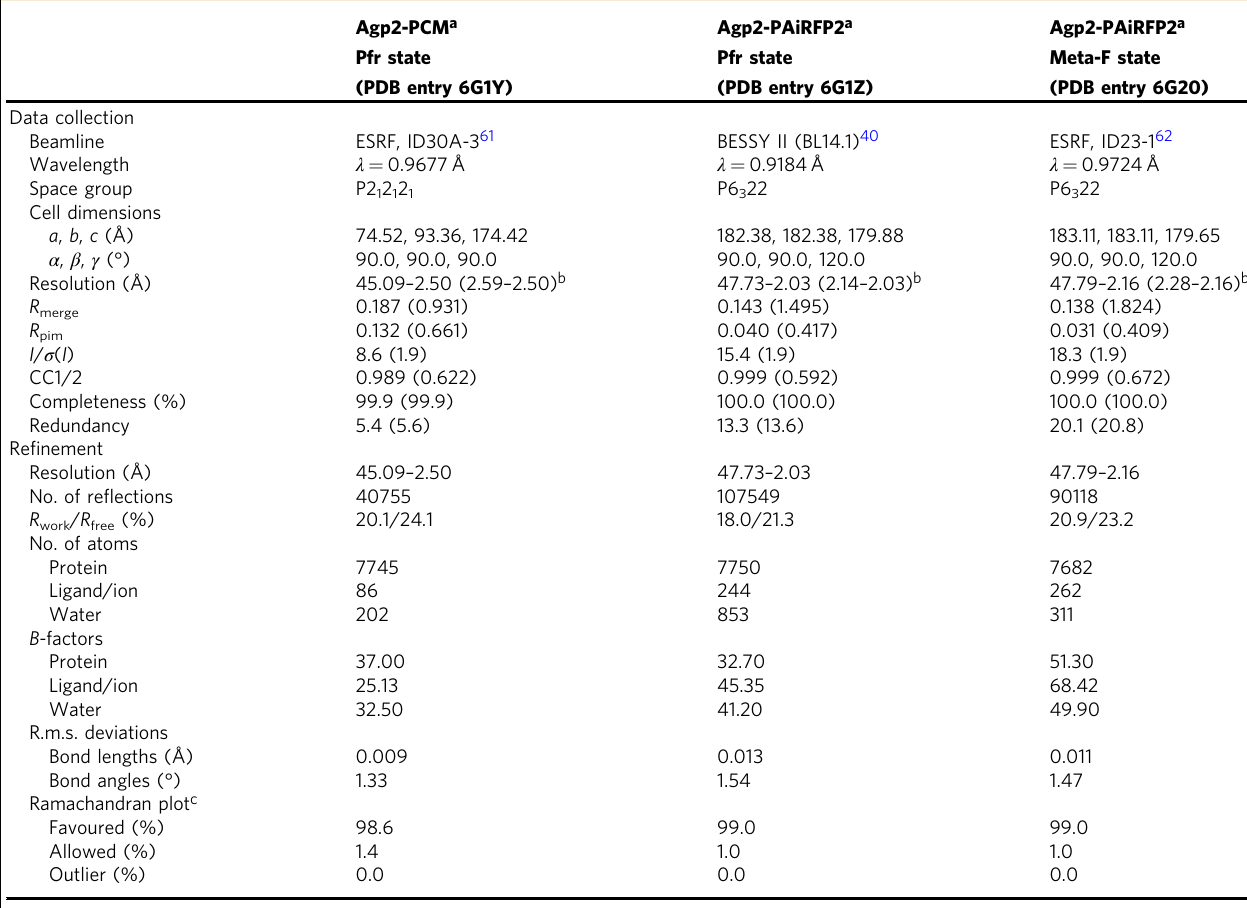
Table 1 Data collection and re fi nement